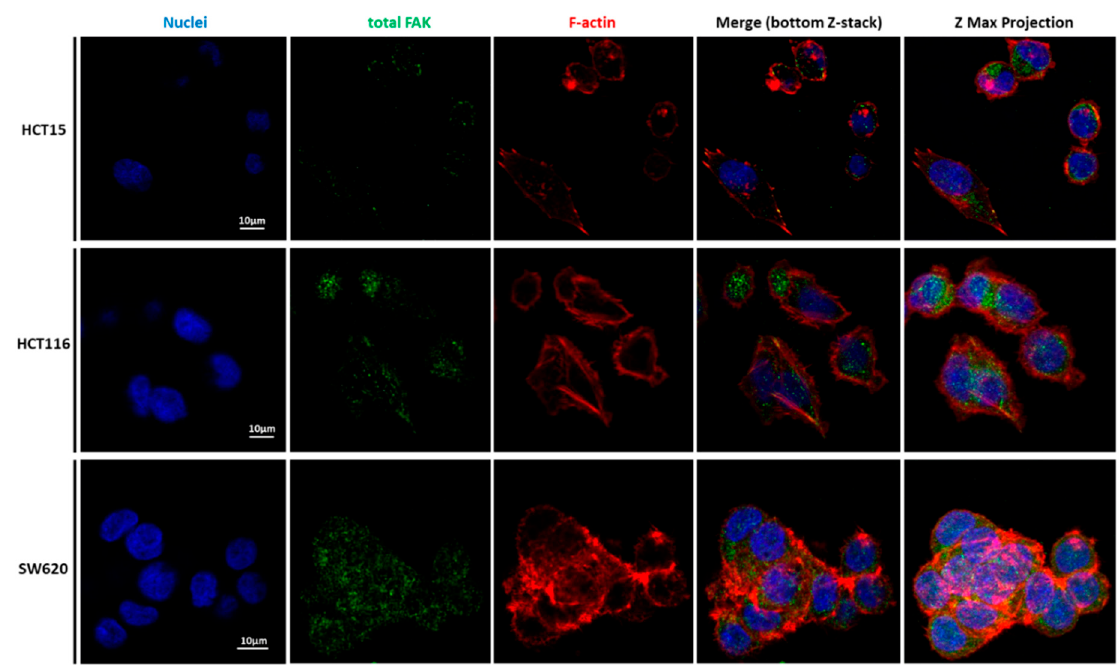
Figure 8. Immunolocalization of FAK in CRC cells. Staining of HCT15 ( top ), HCT116 ( middle ), and SW620 ( lower images ) cells with DAPI to identify the nuclei (blue), phosphorylated FAK (green), and phalloidin for F-actin filaments (red). Shown are the bottom Z-stack and the Z-maximum projection of the imaged area. Scale bars: 10 µm.